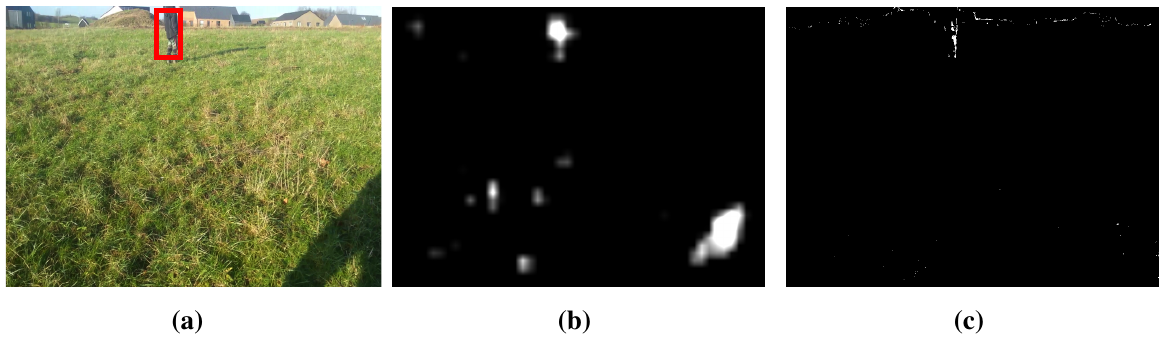
Figure 11. Example of the detection performance with shadows present in the image. ( a ) Detection of a child using the presented algorithm; ( b ) saliency map; ( c ) foreground pixels based on the incremental background